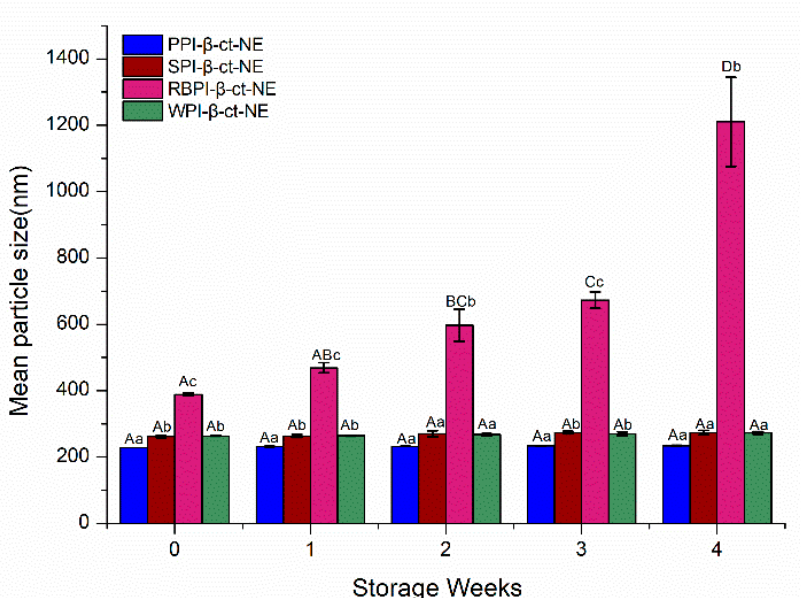
Figure 6. Mean particle sizes of the PPI-, SPI-, RBPI-, and WPI-stabilized nanoemulsions under different storage periods. A–D represent statistically significant differences ( p < 0.05) in mean particle size under different storage weeks in the same sample. a–c represent statistically significant differences ( p < 0.05) in mean particle size between different samples under the same storage week.